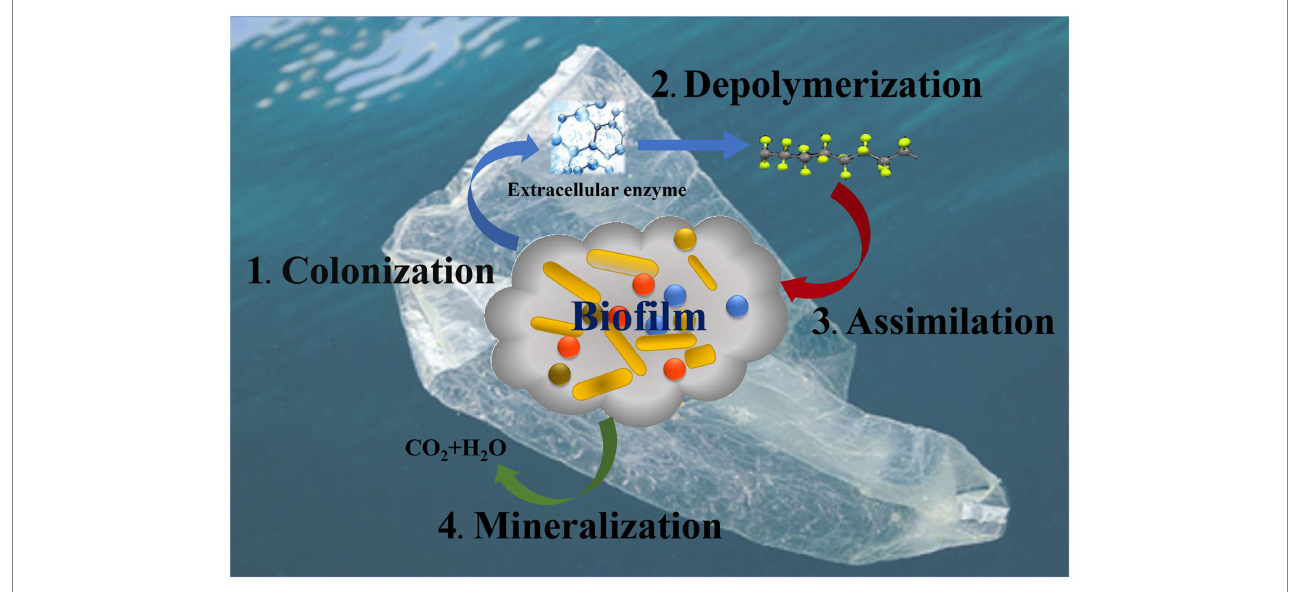
FIGURE 3 The mechanism of microplastic